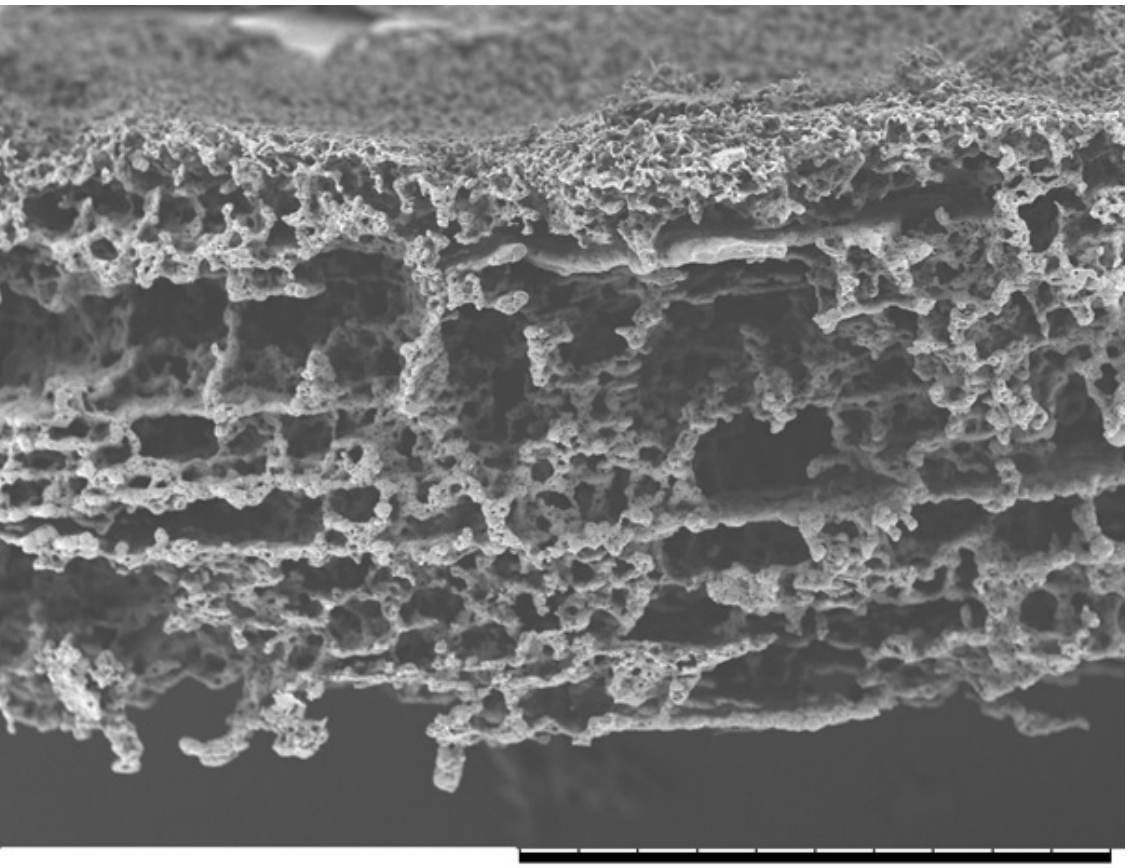
Figure 1. The SEM photomicrographs of the “PVP” membrane.